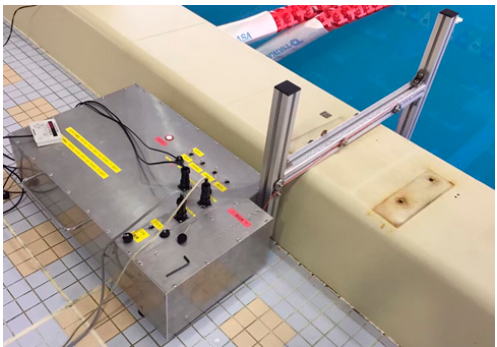
Figure 1. Photographs of the towing device set up in a 25 m swimming pool.